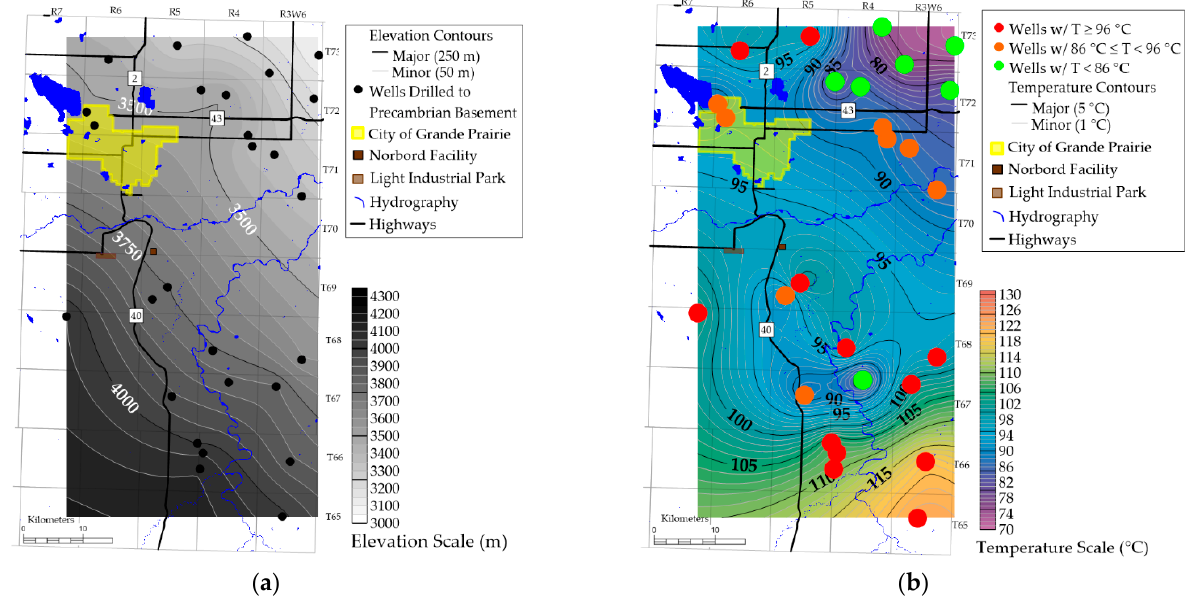
Figure 5. Contour maps of the study area for the Beaverhill Lake Group showing ( a ) depth to the top and ( b ) temperature at the top.